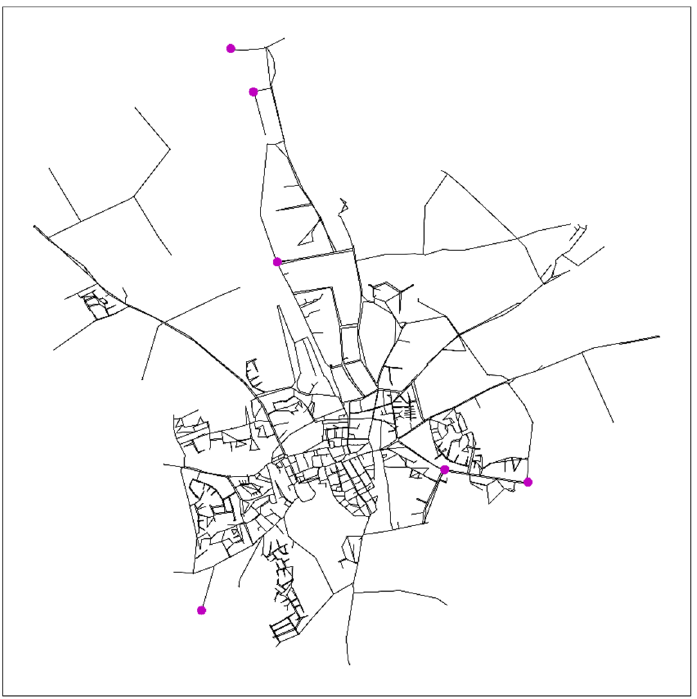
Figure 2. Illustration of the EPANET-model of the drinking water distribution network of City X. Connections to the utility’s transport network (modeled as reservoirs in the hydraulic model) are indicated by a magenta circle.